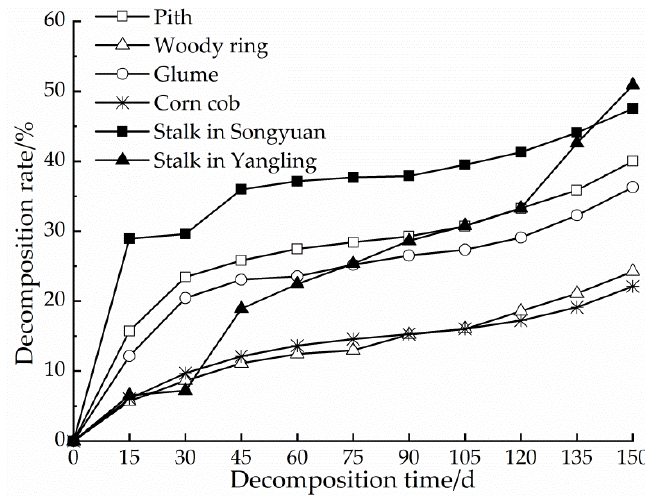
Figure 4. Field decomposition rate of corn cob.